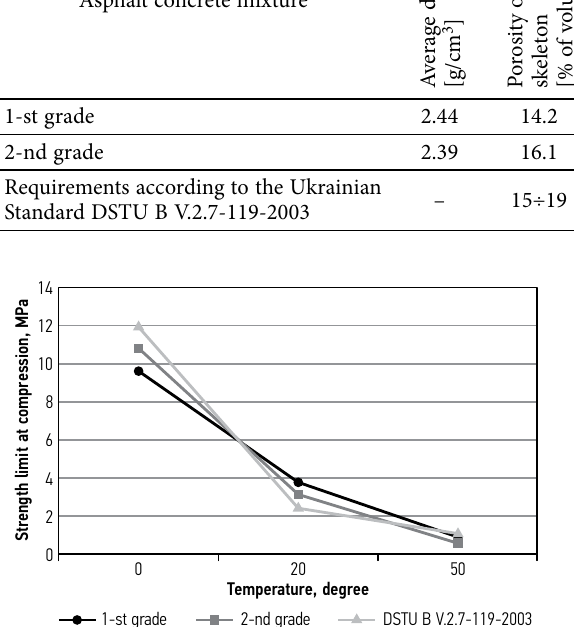
Table 7. Physical and mechanical properties of asphalt concrete of the I and II compound Asphalt concrete mixture